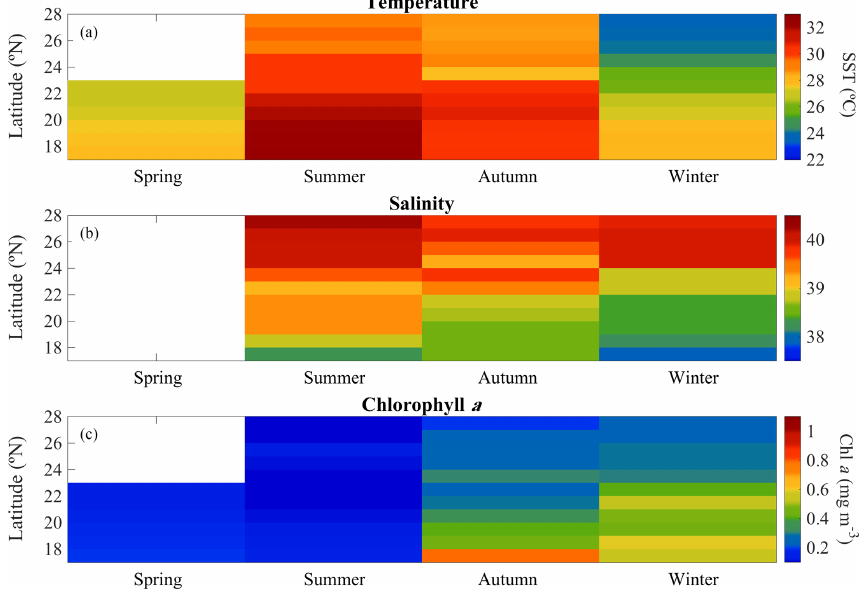
Figure 2. Overall seasonal and latitudinal variability of surface (a) temperature (SST), (b) salinity, and (c) chlorophyll a concentration (Chl a ) measured during spring 2018, summer 2017, autumn 2016, and winter 2016 and 2017 cruises along the Red Sea ( ∼ 100% of incident photosynthetically active radiation, PAR).